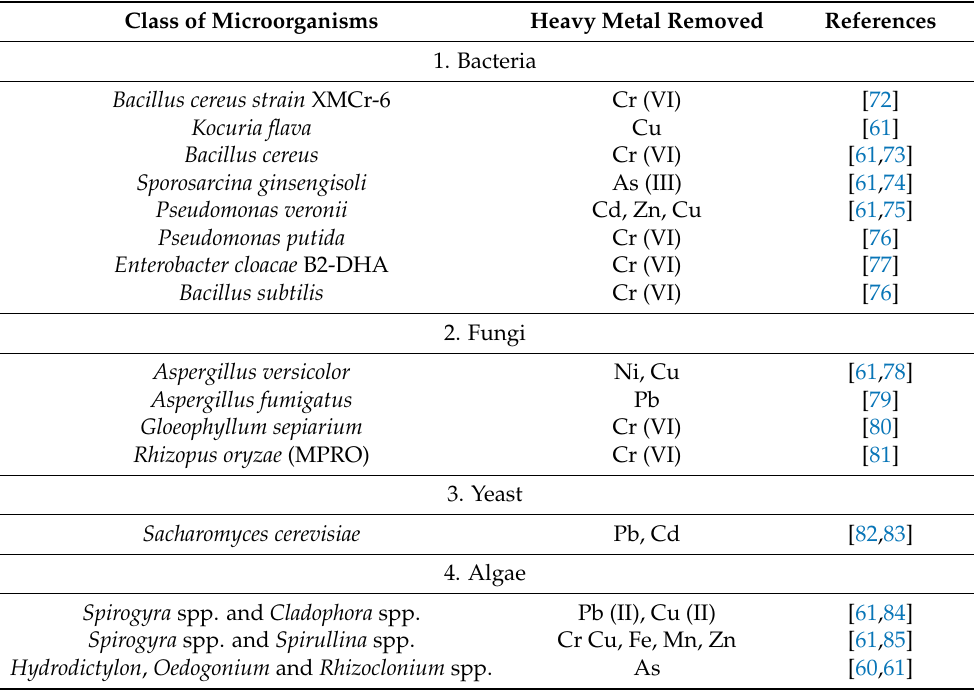
Table 1. Microorganisms used in heavy metal remediation of contaminated